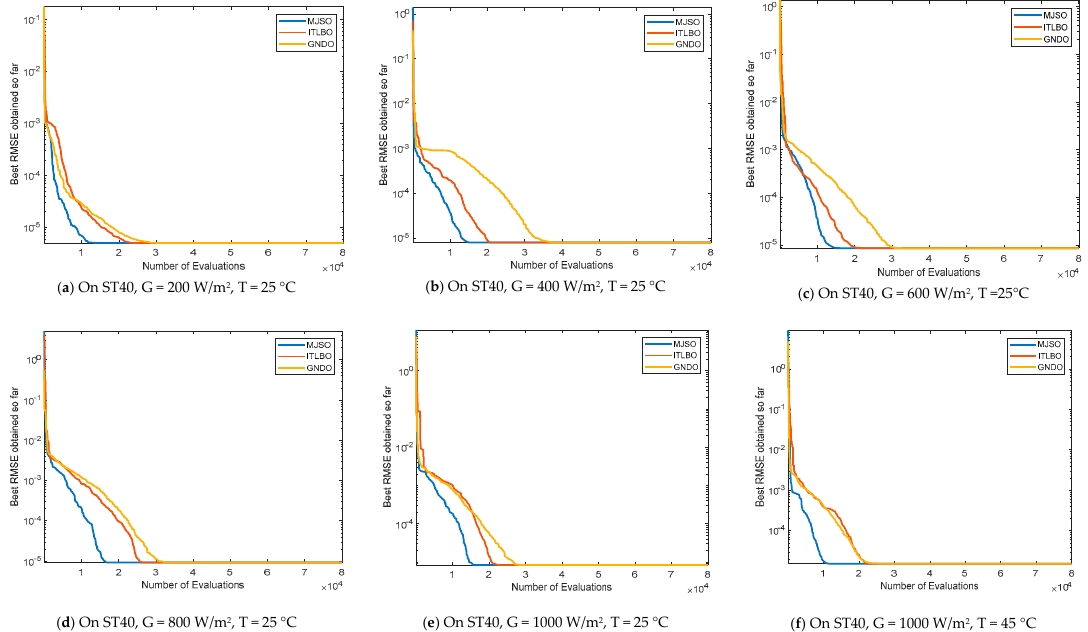
Figure 20. Convergence curve obtained on the ST40 based on SDM under different G and T. Table 17. Comparison at T = 25 ° C and at various G.